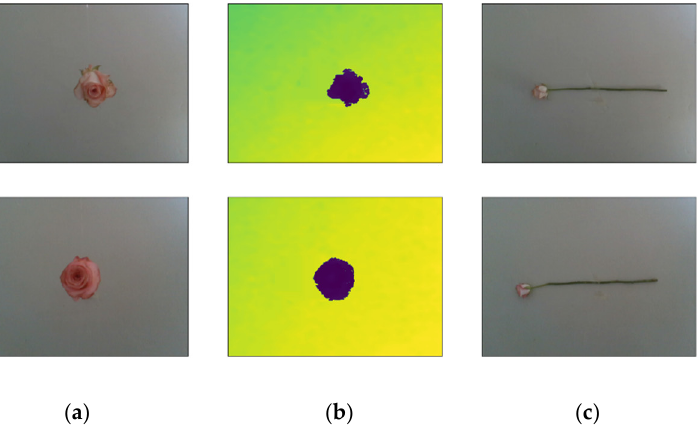
Figure 2. RGB images and depth map of Diana Roses, where ( a ) is an RGB image of the flower bud, ( b ) is a depth map of the flower bud, and ( c ) is the RGB image of the flower stem. After image processing, the contour and a rectangle region of the flower bud were obtained using edge detection, as shown in Figure 3. The obtained rectangular region of the flower bud was used as the dataset for detecting the maturing status using the deep learning method. The dataset contained the RGB image of the flower bud, the depth information of the flower bud, and the maturing status grade of the flower bud.